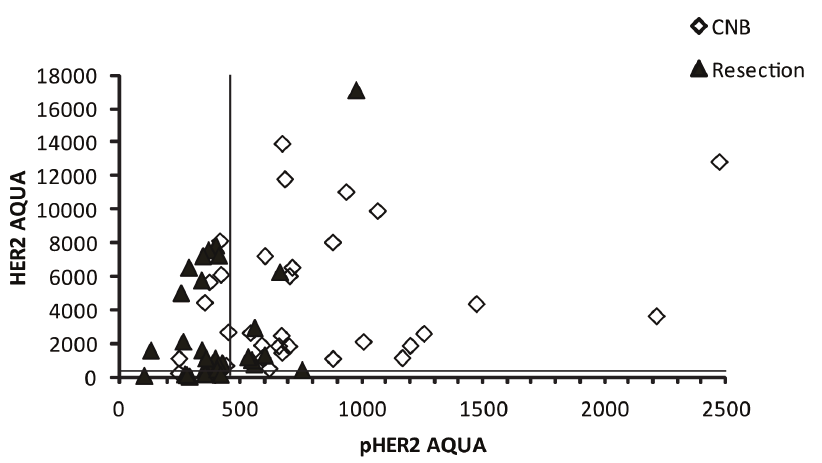
Figure 5. Comparison between pTyr 1248 HER2 and HER2 AQUA. Scatter plot of HER2 and pTyr 1248 HER2 AQUA scores (CNBs, open diamonds; Resections, filled triangles). Lines in the graph represent the noise cut points of either HER2 or pTyr 1248